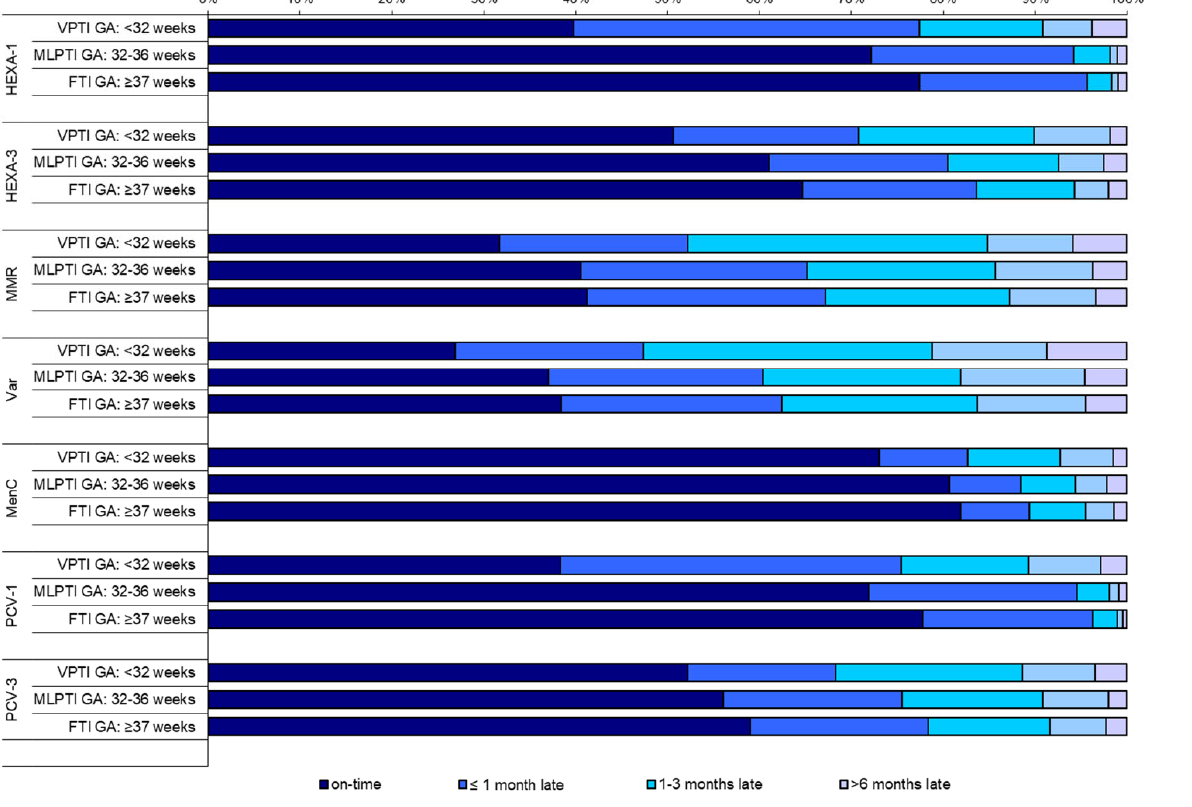
Figure 1. Distribution of vaccination timing (on time, ≤ 1 month late, between 1 and 3 months late, ≥ 6 months late) by prematurity classes (very preterm infants—VPTI; moderate and late preterm infants—MLPTI; full-term infants—FTI) for HEXA-1, HEXA-3, MMR, Var, MenC, PCV-1, and PCV-3 vaccine